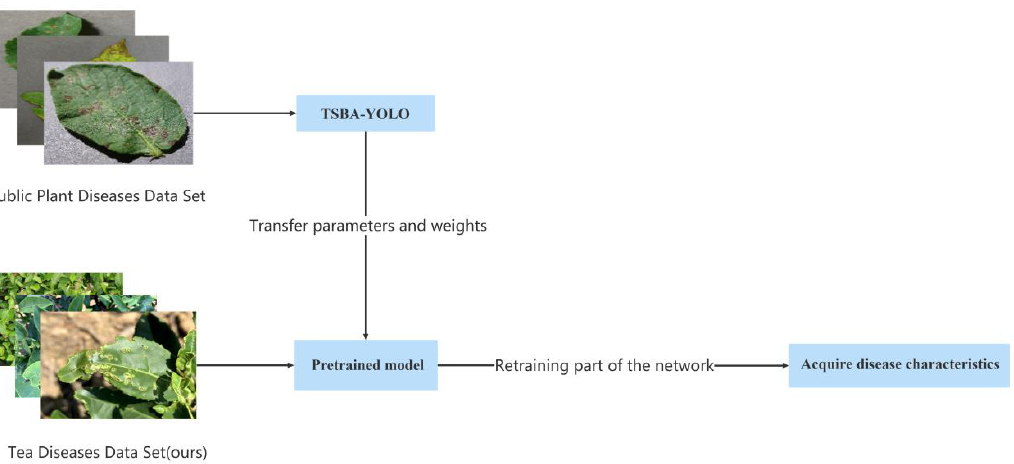
Figure 13. Transfer learning process. TSBA-YOLO is the tea disease detection model proposed in this paper.